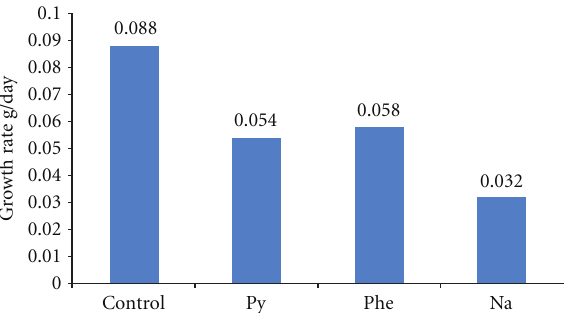
Figure 6: Mean protein concentration of L. vannamei exposed to PAHs for 21